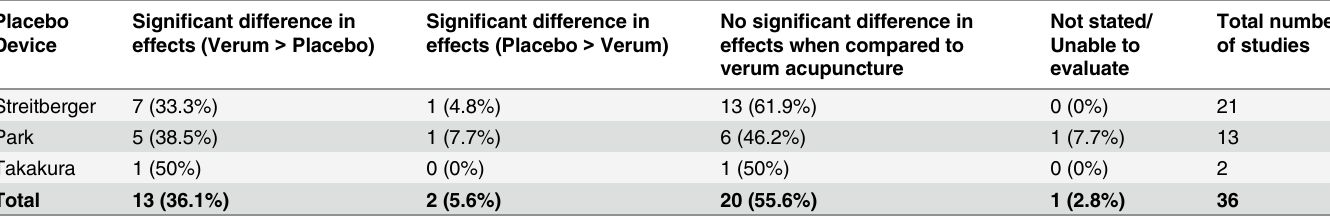
Table 3. Reported difference in effects between verum acupuncture and placebo